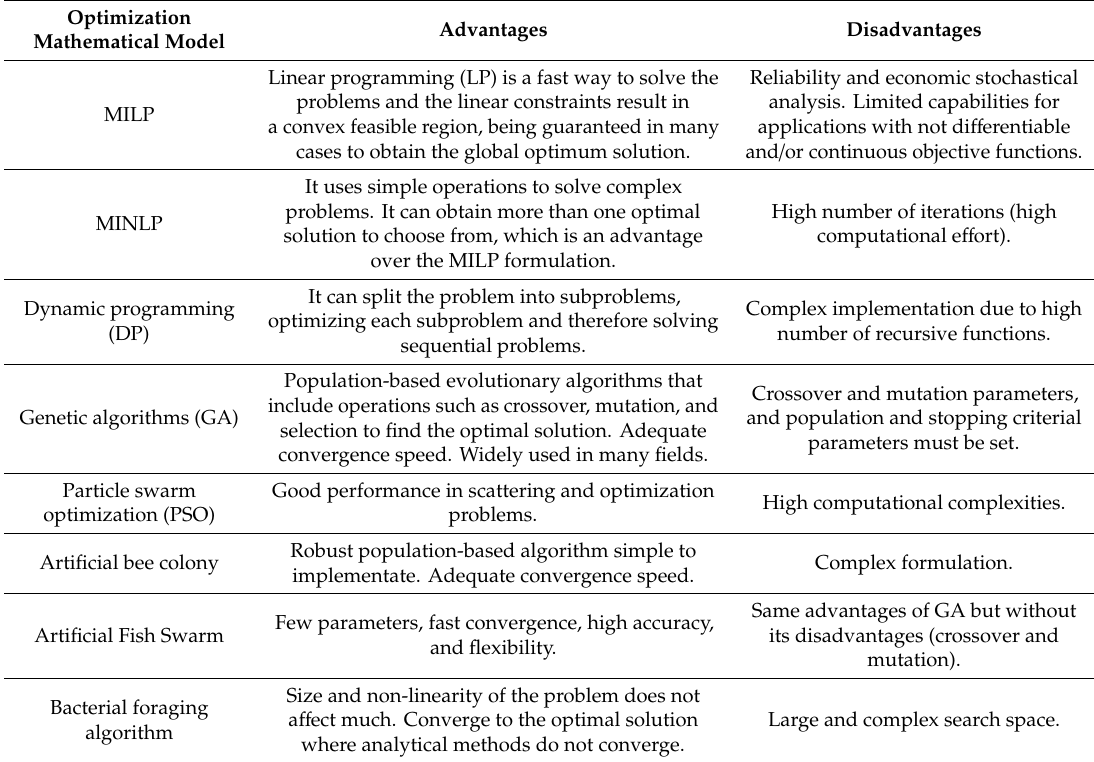
Table 2. Comparative analysis of optimization mathematical